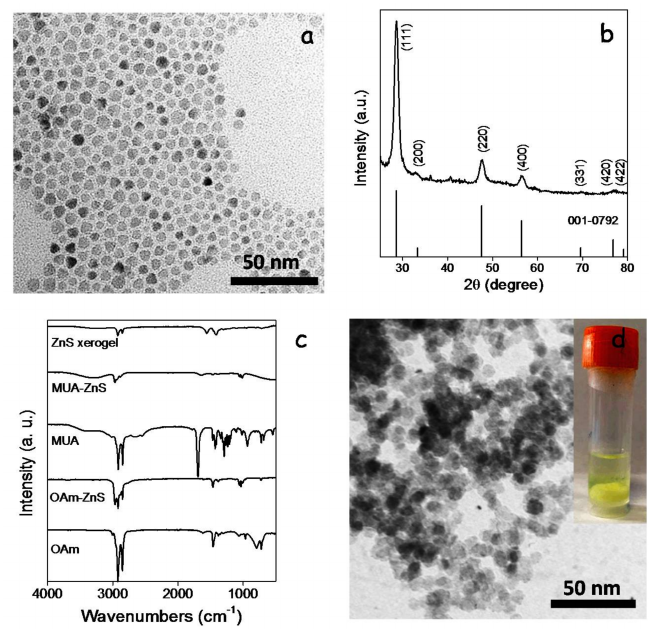
Figure 7. ( a ) TEM micrograph of ZnS NCs; ( b ) XRD pattern of ZnS NCs including the JCPDS 001-0792 phase standard card corresponding to sphalerite ZnS as reference; [21] ( c ) from bottom to top, FTIR spectra of: OAm, as-produced ZnS NCs (OAm-ZnS), MUA, ZnS NCs obtained after ligand exchange with MUA (MUA-ZnS) and ZnS NC-based xerogel; ( d ) TEM micrographs of the ZnS xerogel obtained from MUA-NCs treated with TNM. Inset shows an optical image of the formed ZnS